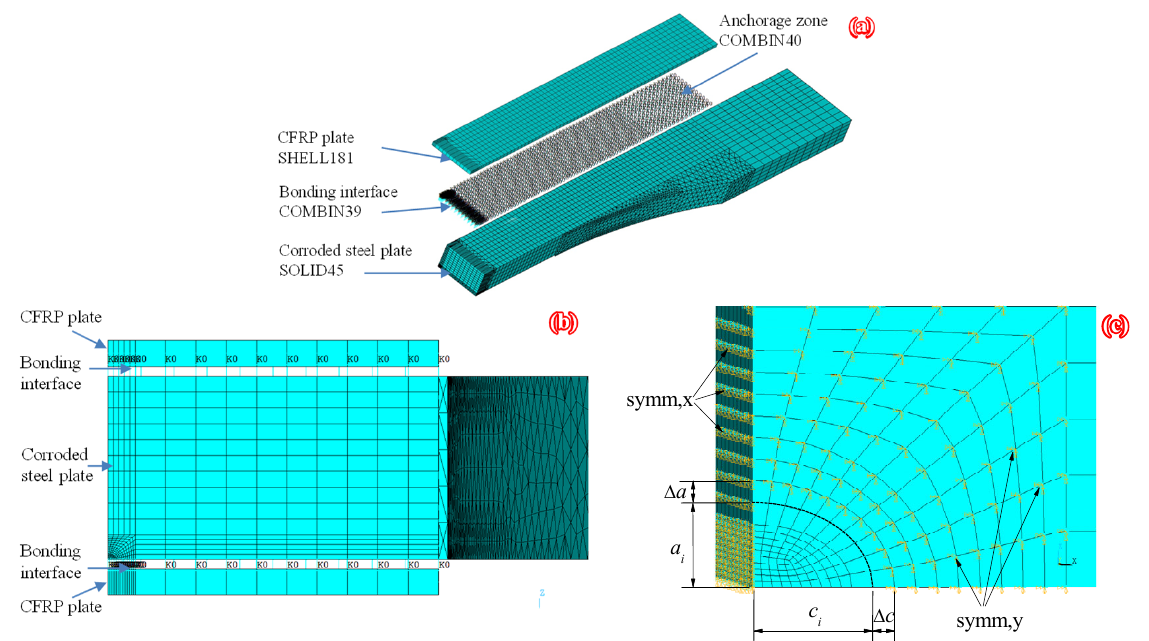
Figure 8. “Brick-Spring-Plate” model: ( a ) Schematic diagram of element selection and division, ( b ) fatigue crack propagation surface in FEM, and ( c ) element division near the crack front in the partial-through crack stage (where a i and c i are the depth and half-width of the crack, respectively, ∆ a and ∆ c are the growth increments of the cracks in the depth and width directions, respectively). the crack tip, so as to calculate the SIF at the crack tip based on Equation (22).